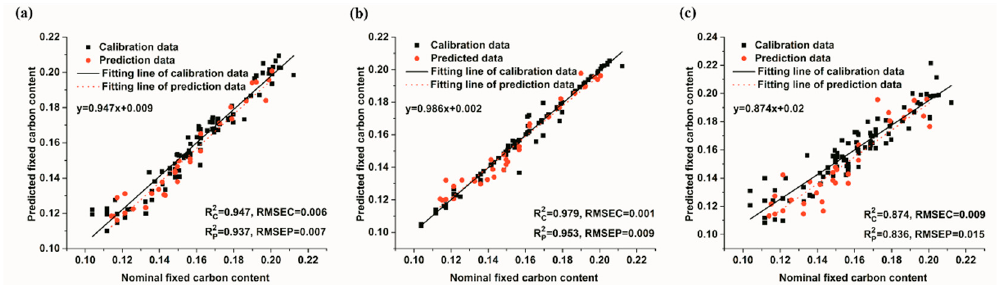
Figure 6. Model fitting results for FC. ( a ) PLSR (partial least-squares regression); ( b ) LS-SVM (the least-squares support vector machine); ( c ) ELM (extreme learning